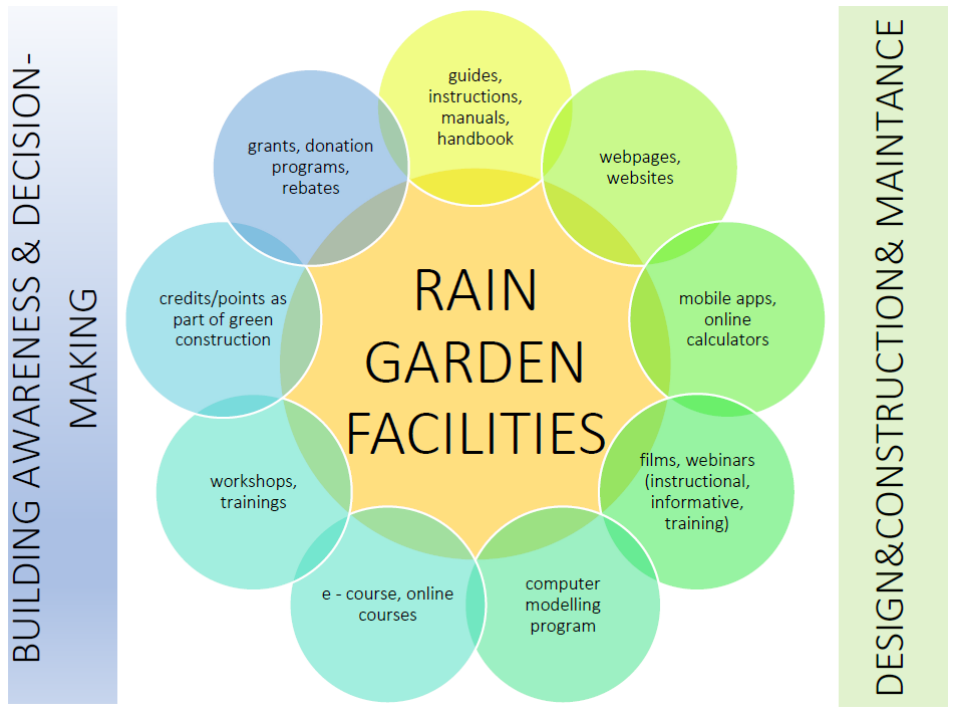
Figure 3. The classification of facilitations of the rain garden application in a city, depending on the implementation stage of the solution.